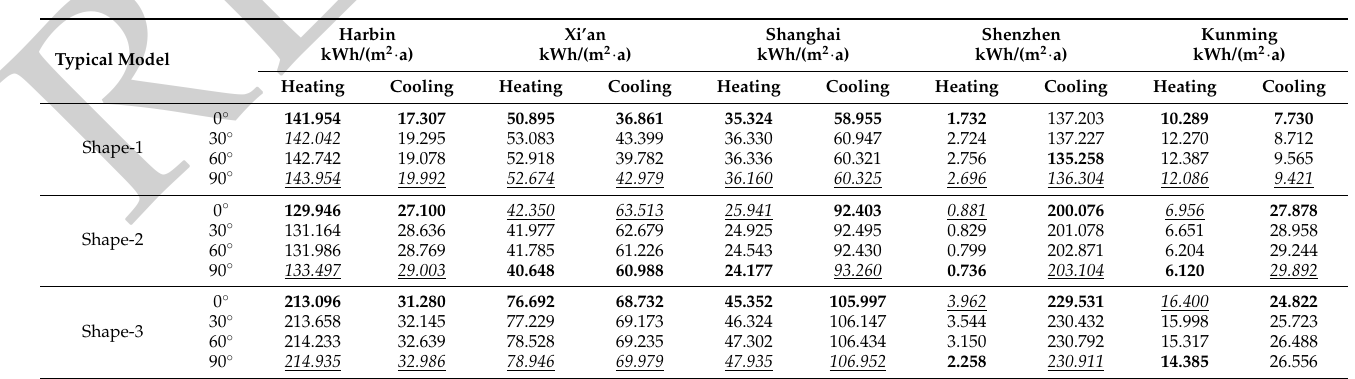
Table 9. The individual energy consumption of heating and cooling in different